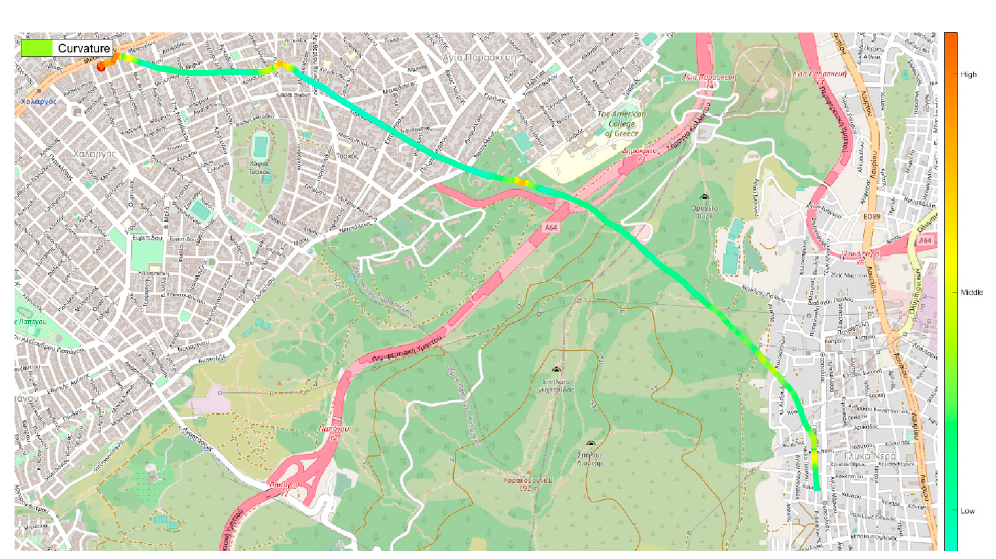
Figure 5. Curvature values on the mouse trajectory. Green values generated during visual search on experimental stimulus. experimental stimulus.